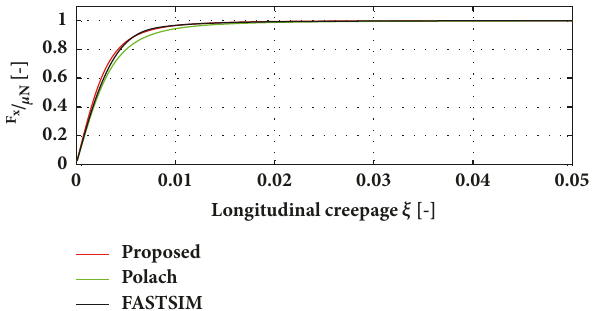
Figure 6: Longitudinal force versus longitudinal creepage in pres- ence of a constant lateral creepage ( 𝜂 = 0.003).